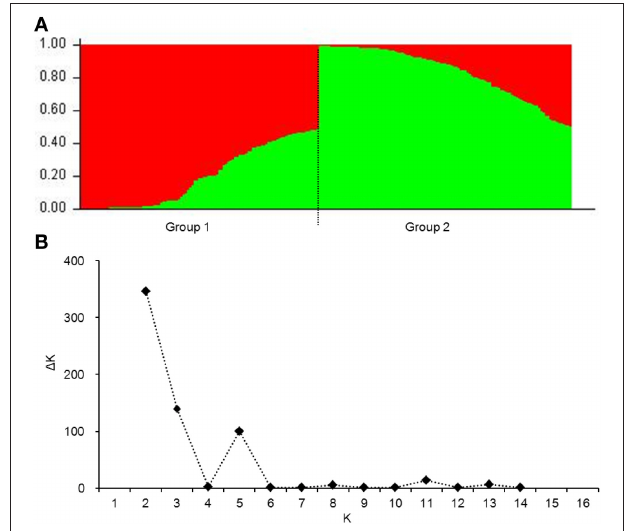
FIGURE 2 | Population structure of 220 wheat cultivars based on 106 genome-wide SSR markers. (A) , genetic structure produced by Structure V2.3.2; (B) , number of sub-populations estimated by 1 K at a range of K